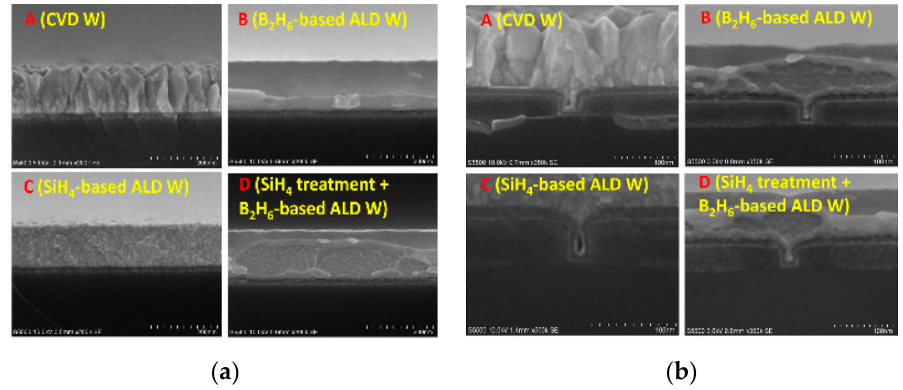
Figure 27. Cross-sectional SEM pictures of W films grown in different conditions: ( a ) On blank wafers and ( b ) trenches filling capacity [166].